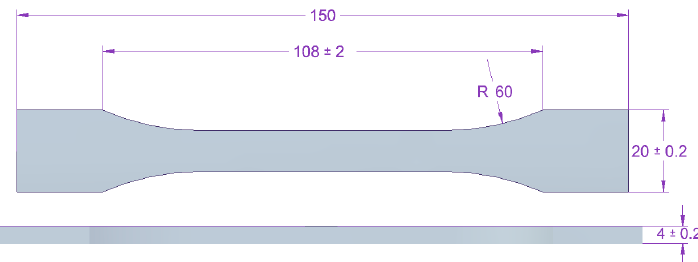
Figure 2. Shape and dimensions of adhesive compositions sample for tensile strength testing according to PN EN ISO 527-2 [29]. (Unit: mm)